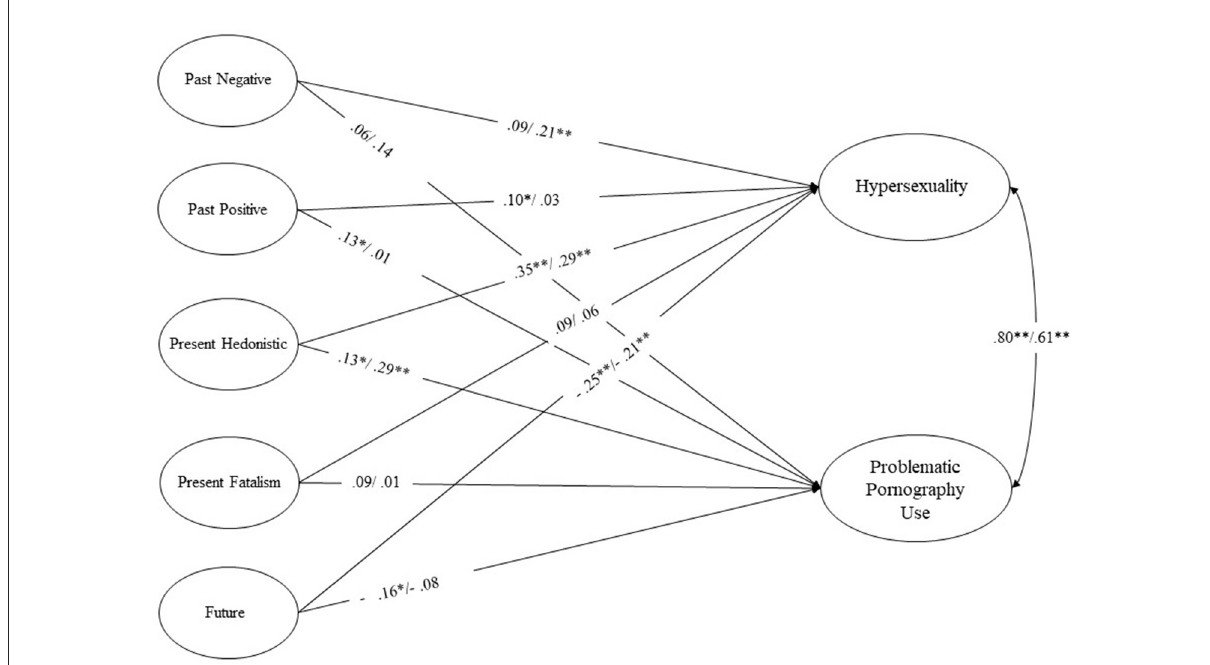
FIGURE1 Examining the associations between time perspectives, hypersexuality, and problematic pornography use. All variables presented in ellipses are latent variables. One-headed arrows represent standardized regression weights, and two-headed arrows represent correlations. Numbers on the arrows represent standardized path coefficients (Sample 1 and Sample 2, respectively). Associations that are significant at the p < 0.05 level are marked with *, and at the p < 0.01 level are marked with